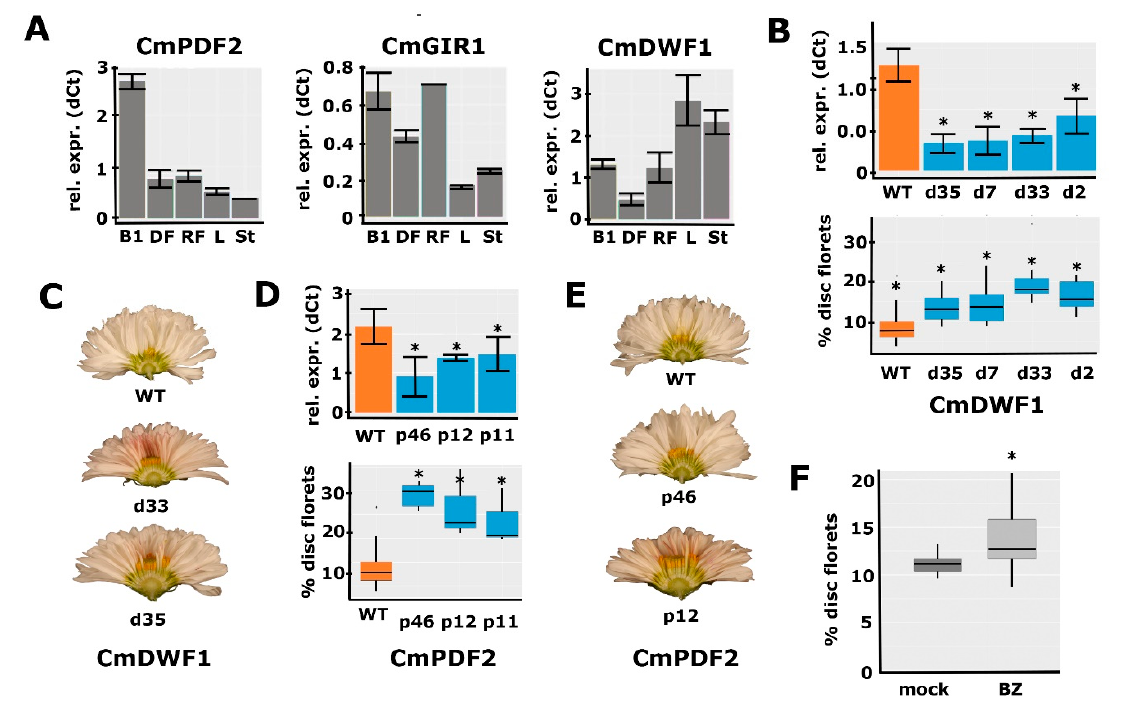
Figure 4. Functional characterization of CmPDF2 , CmGIR1 , and CmDWF1 . ( A ) qPCR analysis of CmPDF2 , CmGIR1 , and CmDWF1 expression in different tissues. B1, bud stage 1; DF, mature disc florets; RF, mature ray florets; L, leaf; St, stem. ( B ) Downregulation of CmDWF1 transcripts in different RNAi lines (top panel) and the quantification of the corresponding capitulum phenotypes (bottom panel) ( C ) Transverse sections of the capitula of two lines with CmDWF1 downregulation compared to the WT (top). A higher number of disc florets is visible in the center of the transgenic capitula. ( D ) Downregulation of CmPDF2 transcripts in different RNAi lines (top panel) and the quantification of the corresponding capitulum phenotypes (bottom panel). ( E ) Transverse sections of the capitula of two lines with CmPDF2 downregulation compared to the WT (top). A higher number of disc florets is visible in the center of the transgenic capitula. ( F ) Brassinozole treatment of WT inflorescence buds results in a higher number of disc florets. Error bars indicate SE; asterisks indicate significance (qPCR: p < 0.05; RNA-seq: Padj < 0.01). tion lines were generated in C. morifolium cultivar ‘1581’. Based on the di ff erential expres- sion observed in the M1/M2 mutant backgrounds, we hypothesized that transgenic lines M1/M2 phenotypes and exhibit more disc fl orets in the capitulum. For each transfor- mation, at least 12 independent transgenic lines were selected, and the downregulation of